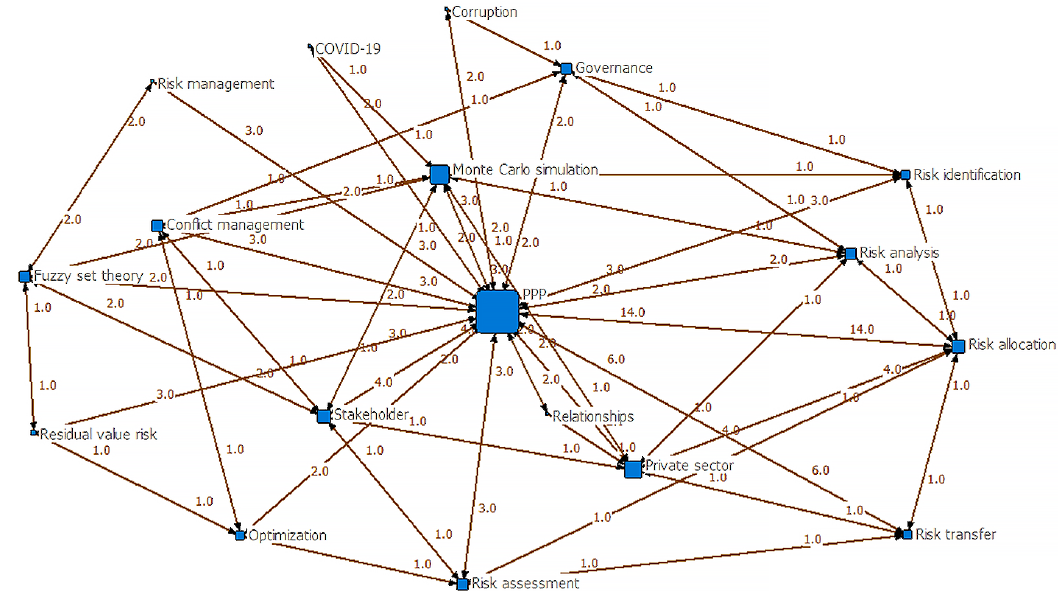
Figure 4. Risk management topics in